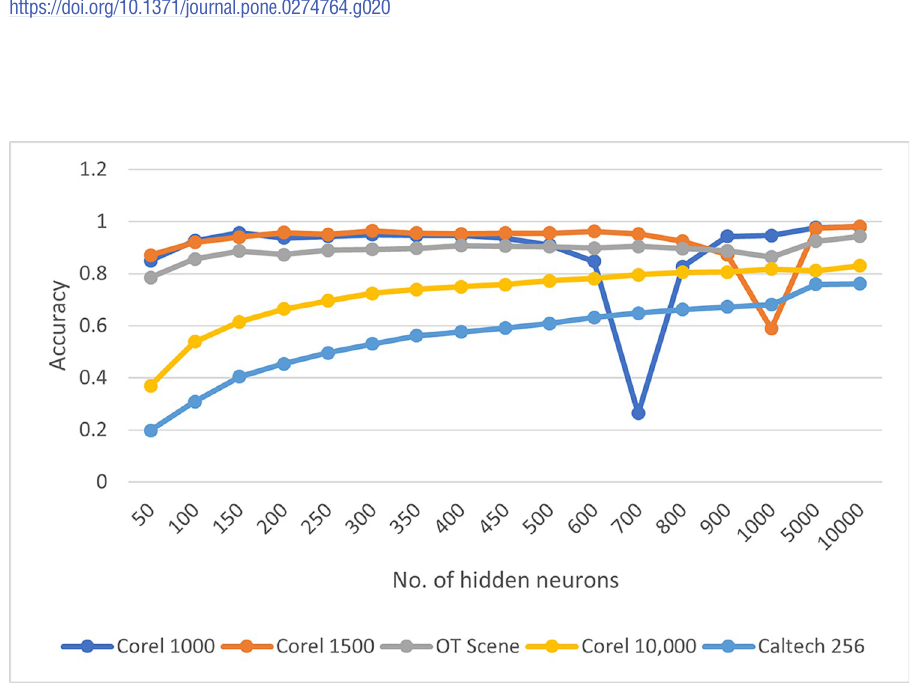
Fig 21. Effect of no. of hidden neurons on the accuracy of the proposed method.